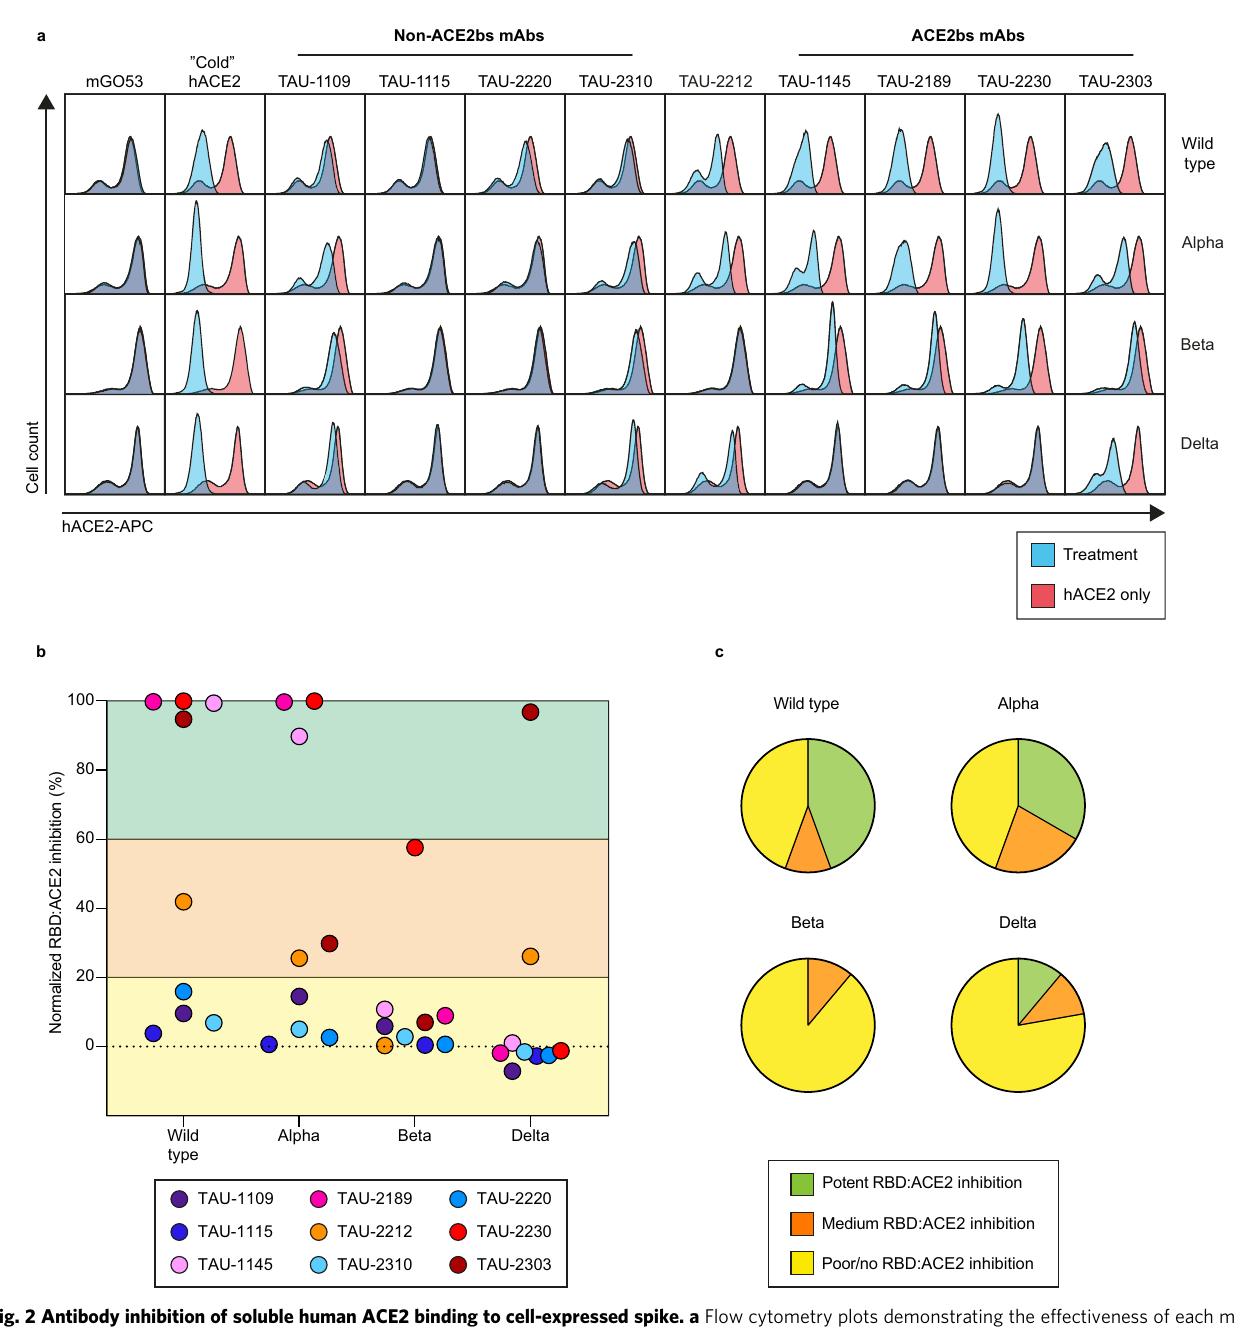
Fig. 2 Antibody inhibition of soluble human ACE2 binding to cell-expressed spike. a Flow cytometry plots demonstrating the effectiveness of each mAb when interfering with spike:ACE2 binding (see Supplementary Fig. 2 for more details). Expi293F cells were transfected to express the wild type, Alpha, Beta, or Delta spike, and were incubated with each antibody, before being stained with human ACE2 (hACE2) conjugated to APC. Unlabeled hACE2 ( “ cold ” hACE2) was used as a positive control, and mGO53 66 antibody as an isotype control. Within each plot, the blue histogram indicates treated cells, while the red indicates untreated. Each experiment was repeated at least three times ( n ≥ 3). b Normalized percent of spike:ACE2 inhibition, calculated by measuring the percent of hACE2-APC positive cells in the presence of each mAb, dividing it by the percent of hACE2-APC positive cells (hACE2 only), and normalizing to 100%. c Pie charts indicating the frequency of spike:ACE2 inhibiting mAbs for wild type and